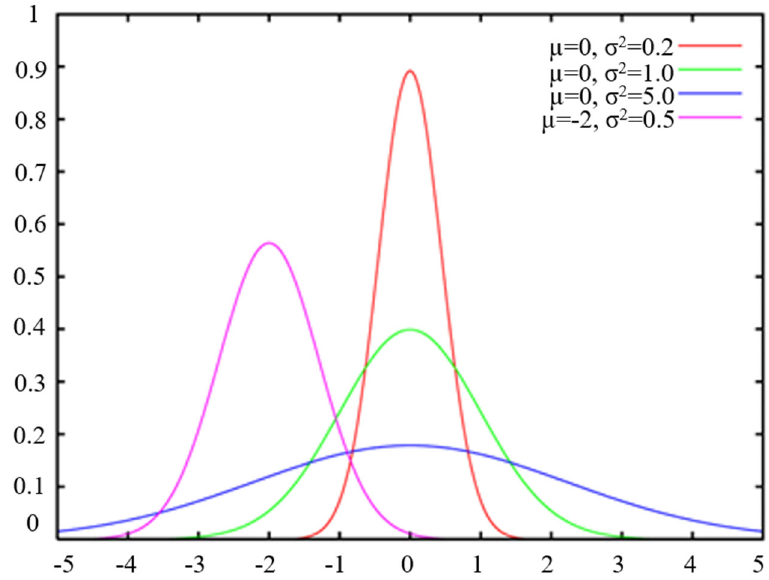
Figure 2. Normal distribution curve.